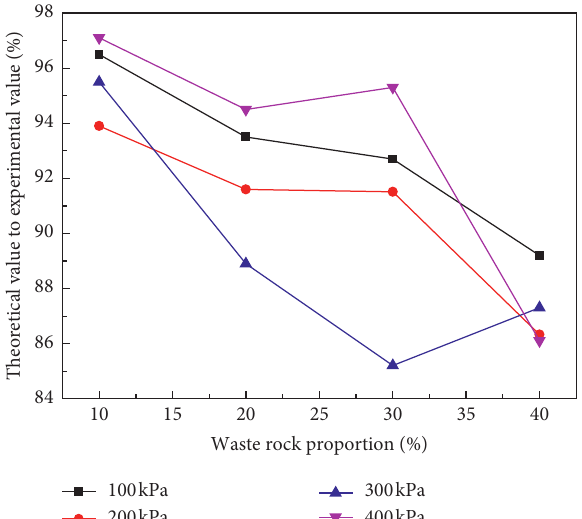
Figure 7: Relationship between the waste rock proportion and the ratio of the theoretical value to experimental value of shear strength.